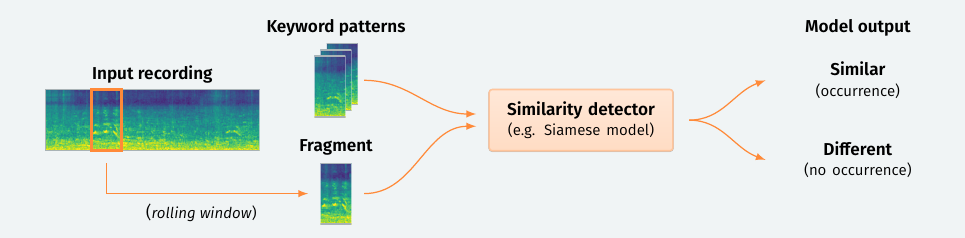
Figure 1. Keyword detection based on audio similarity matching. This schematic depicts a typical pipeline. An input recording is processed sequentially with a short rolling window (e.g., 800 ms). The system compares each extracted fragment to a set of exemplary patterns predefined for each keyword. The model then outputs a decision based on the distance between the fragment and each pattern. If the distance is sufficiently small, a keyword occurrence is emitted for a given